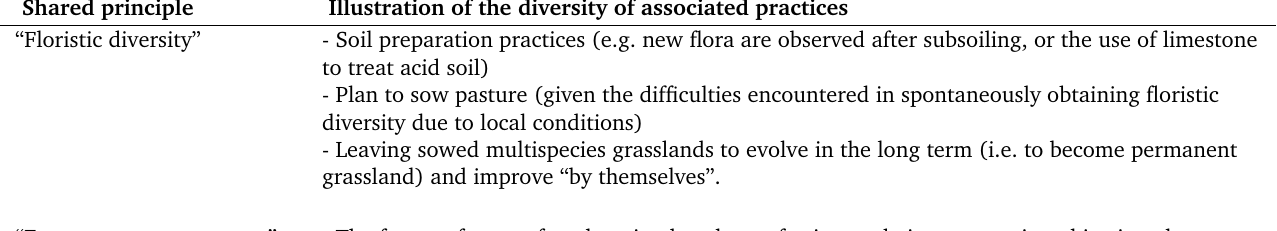
Table 2. Examples of the range of practices associated with a shared principle Shared